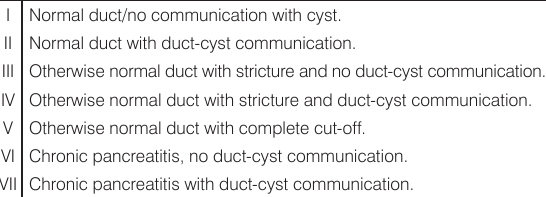
Table 2. Pancreatic duct anatomy according to Nealon’s